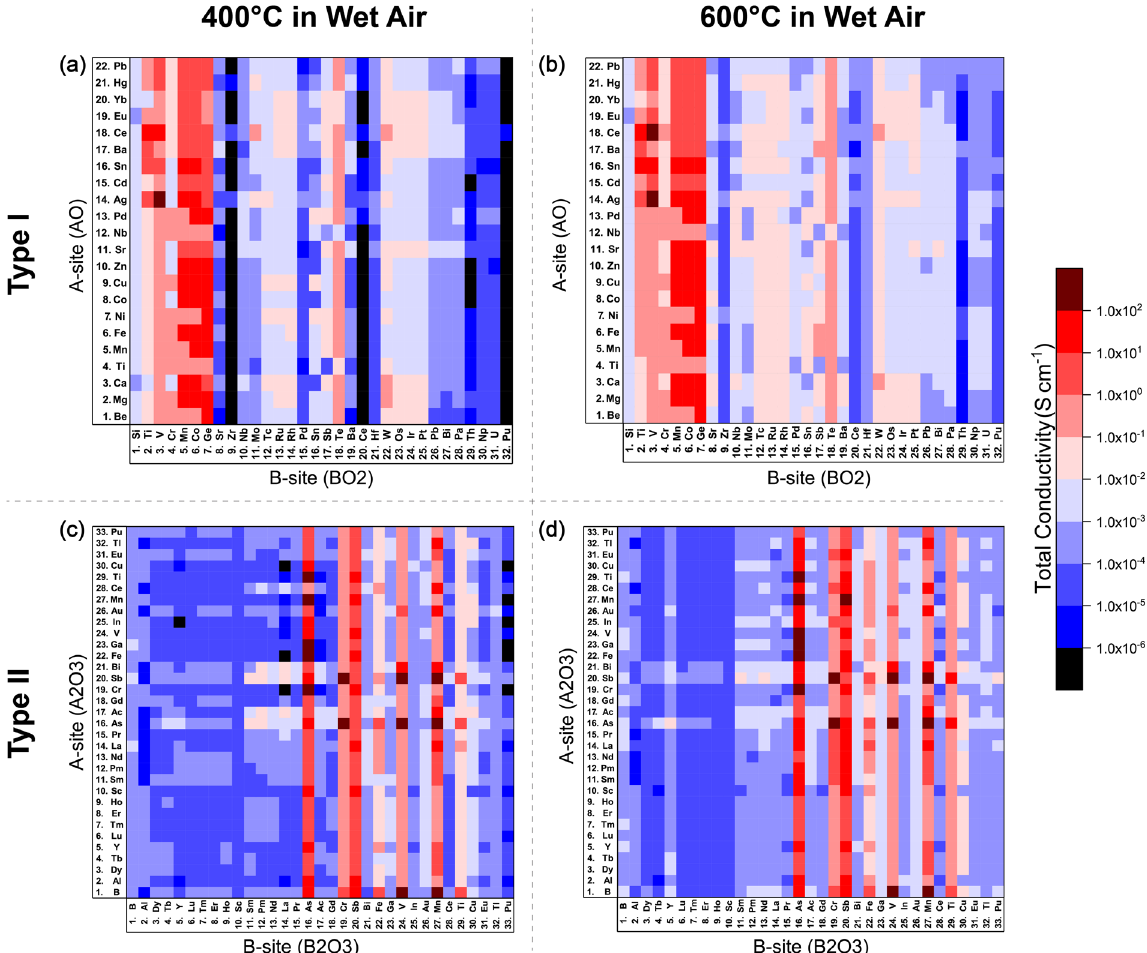
Fig. 3 The effect of temperature on total conductivity of screened (from ML model) perovskites. Type I (AO + BO 2 ), shown in plots a and b , and type II (A 2 O 3 + B 2 O 3 ), shown in plots c and d , perovskites. The conductivities are shown at a temperature of 400 °C ( a , c ) and 600°C ( b , d ). The increase in conductivity (e.g., indicated by change of color as observed in column 9 for zirconates in a and b ) with temperature